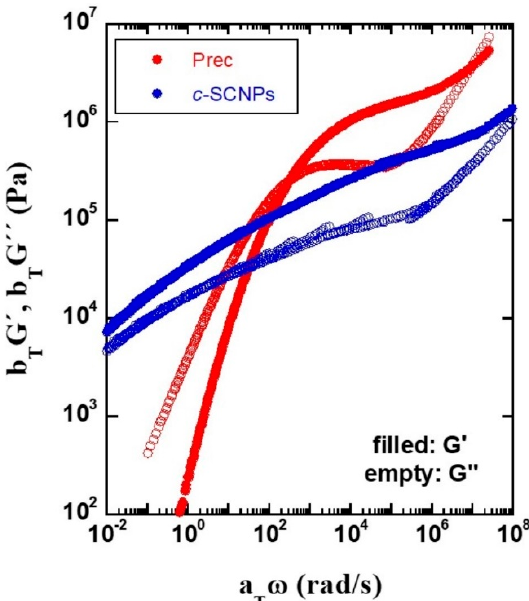
Figure 2. Rheological master curves (reference temperature: 293 K) for precursor and c -SCNPs.